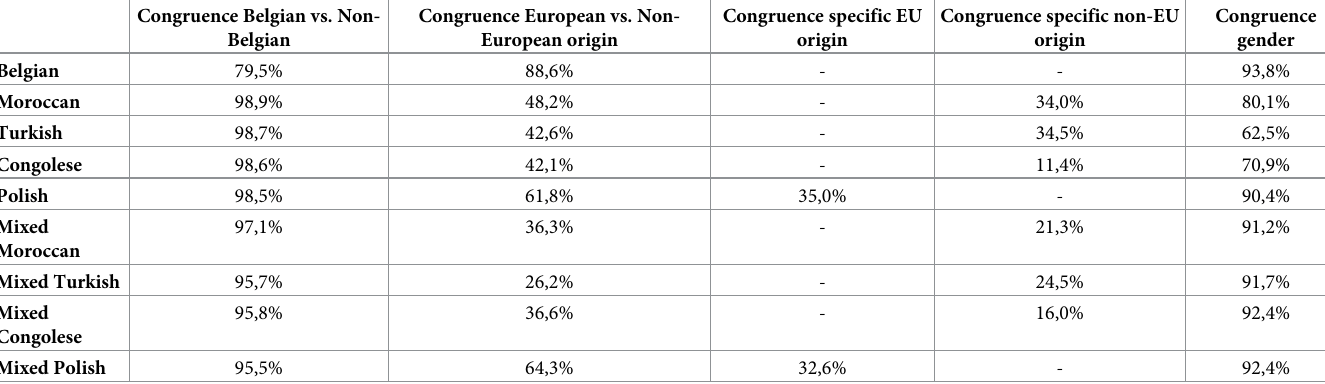
Table 1. Mean congruence rates for gender and ethnic-national origin. Congruence Belgian vs. Non-